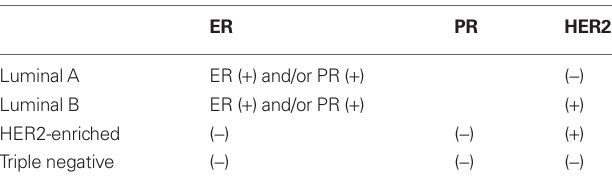
Table 1 | Immunohistochemically defined breast cancer molecular